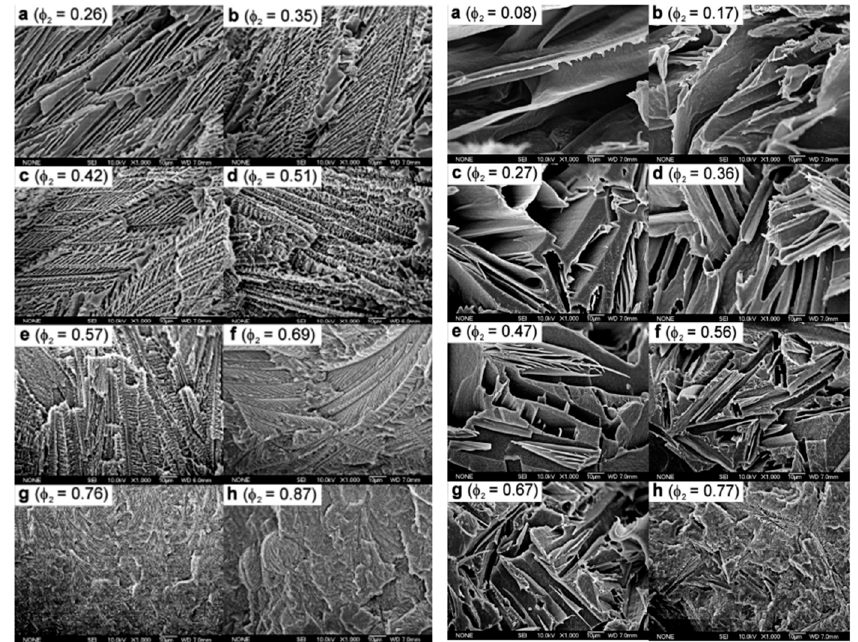
Figure 9. SEM micrographs showing the morphology of the fractured cross-sections of PE-diluent mixtures after extraction. Φ 2 represents the volume fraction of LLDPE: (left) LLDPE/pyrene and (right) LLDPE/hexamethylbenzene (HMB), reprinted (adapted) with permission from [90] . Copyright (2009) American Chemical Society.